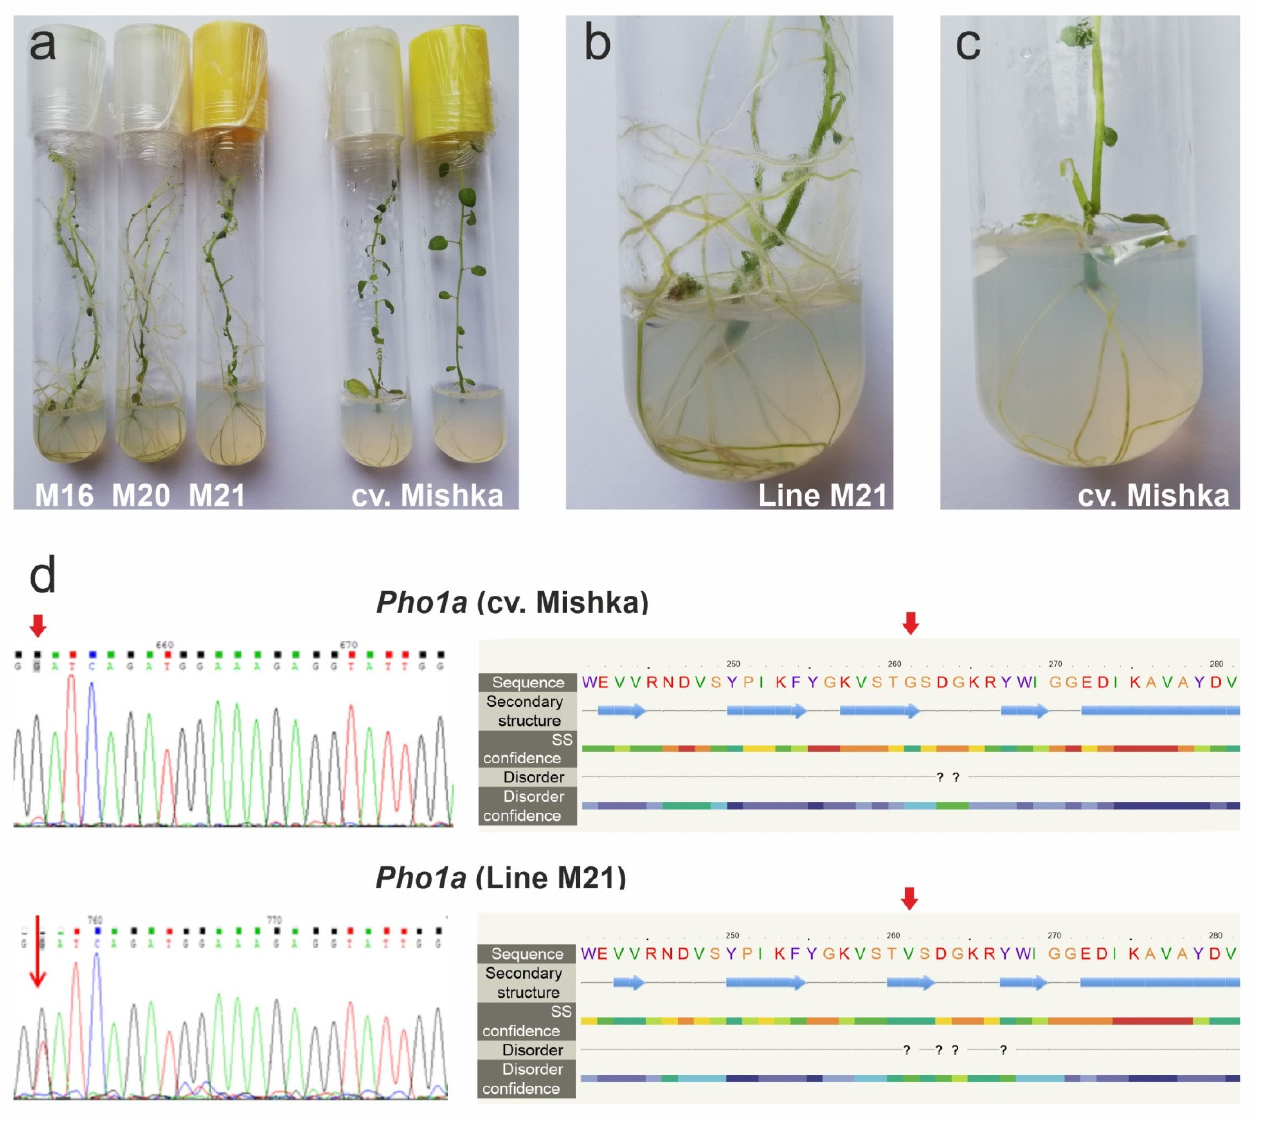
Figure 1. Morphological effects of PHO1a gene editing. ( a – c ) Photographs of wild-type plants and PHO1a-edited transgenic lines M16, M20, and M21 of cv. Mishka. ( d ) Comparison of the PHO1a target region (on the left) and the corresponding protein secondary structure according to Phyre2 (on the right). Arrows point to the target site.